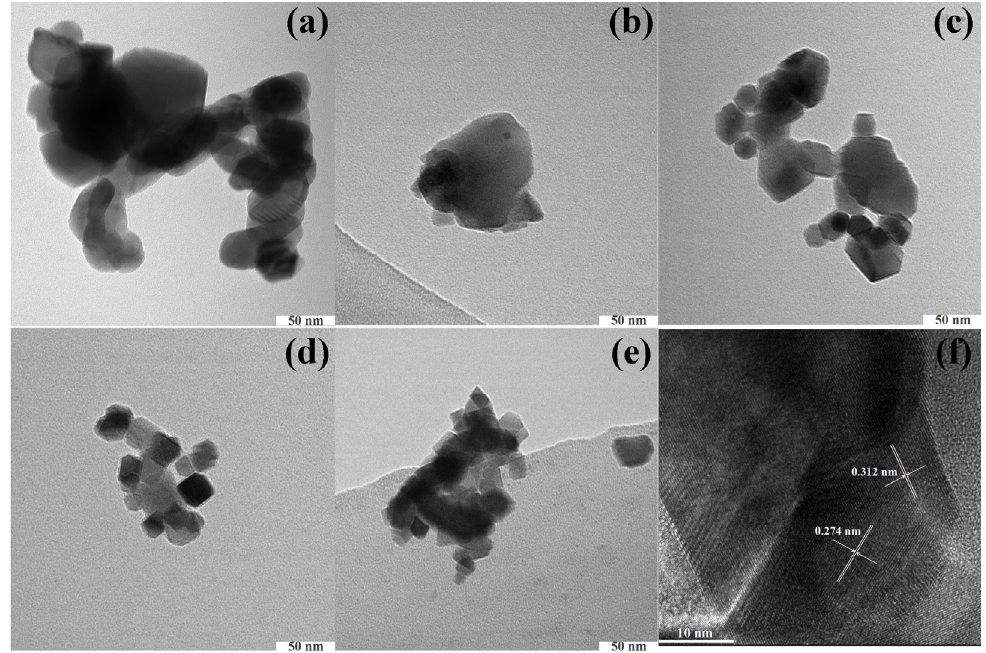
Figure 6. TEM images of ( a ) SrCoO 3 − x ; ( b ) SrCo 0.95 Mn 0.05 O 3 − x ; ( c ) Sr 0.5 Ba 0.5 CoO 3 − x ; ( d ) Sr 0.5 Ba 0.5 Co 0.95 Mn 0.05 O 3 − x ; ( e ) Sr 0.5 Ba 0.5 Co 0.90 Mn 0.10 O 3 − x ; HRTEM images of ( f ) Sr 0.5 Ba 0.5 Co 0.95 Mn 0.05 O 3 − x. The OER electrocatalytic properties of Sr 0.5 Ba 0.5 Co 0.95 Mn 0.05 O 3 − x and Sr 0.5 Ba 0.5 Co 0.90 Mn 0.10 O 3 − x were evaluated by a standard three-electrode system in an O 2 -sat-